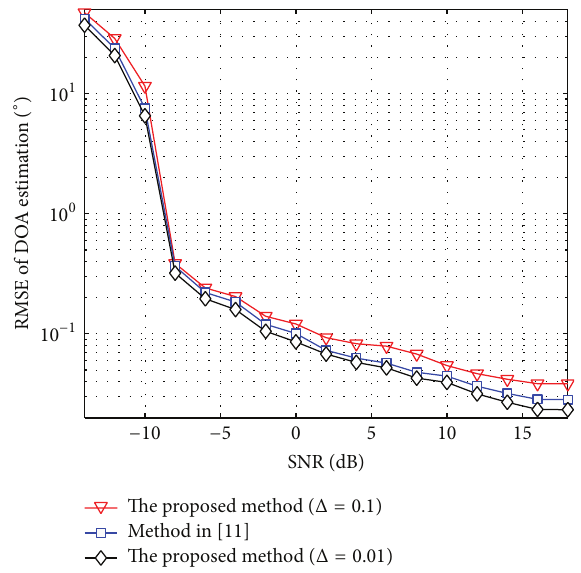
Figure 3: RMSE of the DOA estimates versus input SNR.